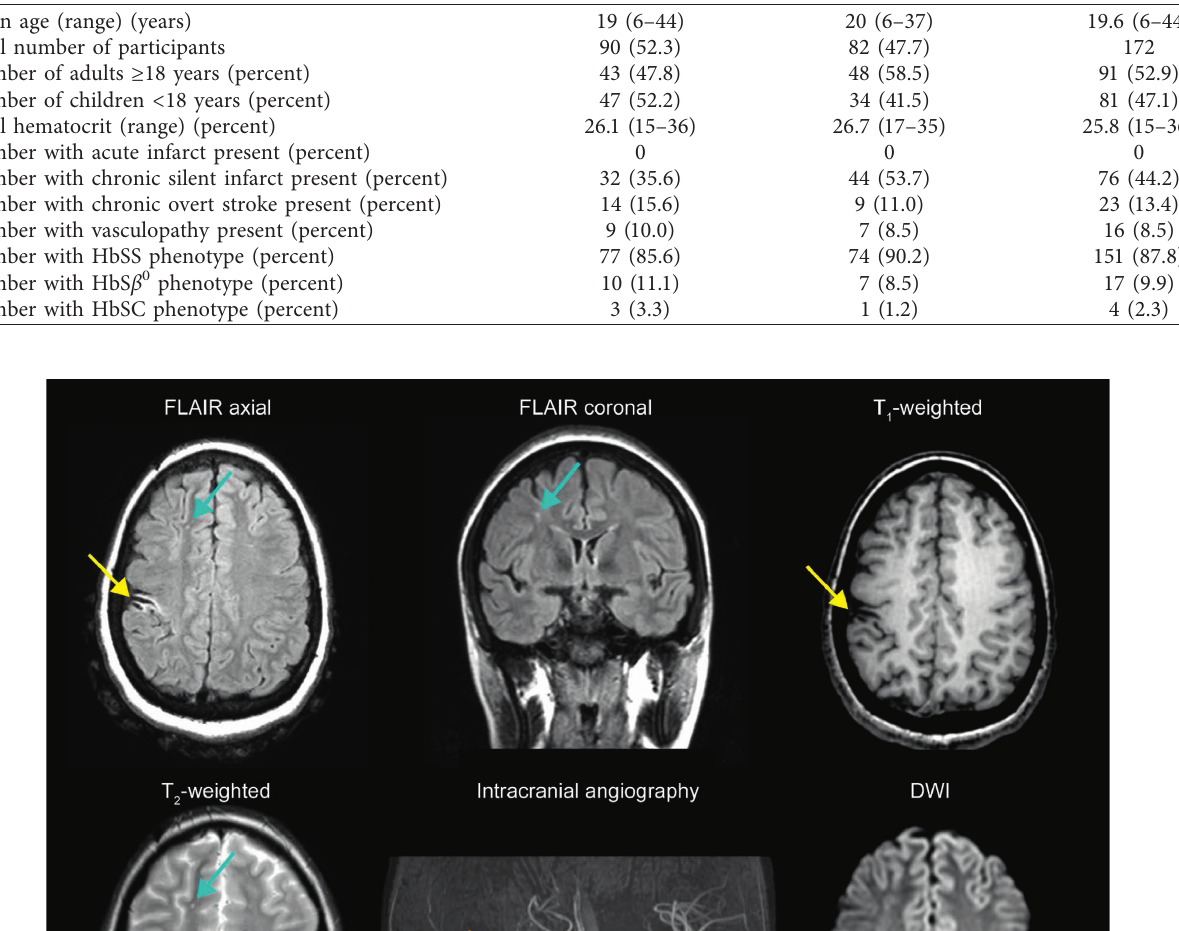
Table 1: Sickle cell disease (SCD) participant demographics and percentage with acute, overt, and silent stroke.